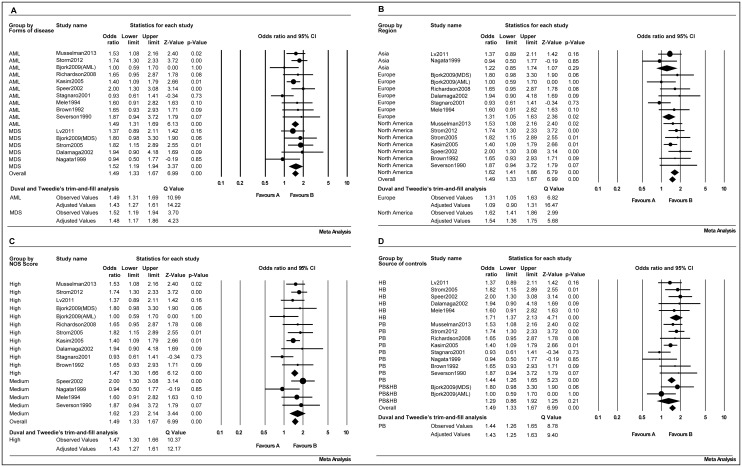
Forest plots of the risk of adult myeloid disease in current smokers.(A) Forms of disease, (B) geographical region, (C) NOS score (high and medium quality), (D) source of controls.